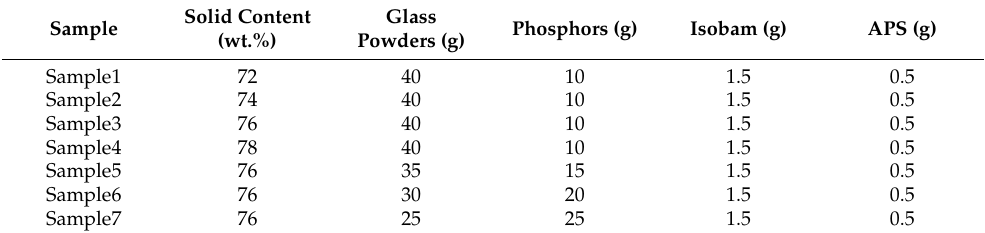
Table 1. Composition of samples with different ratios of phosphors and glass powders. Solid Content Sample